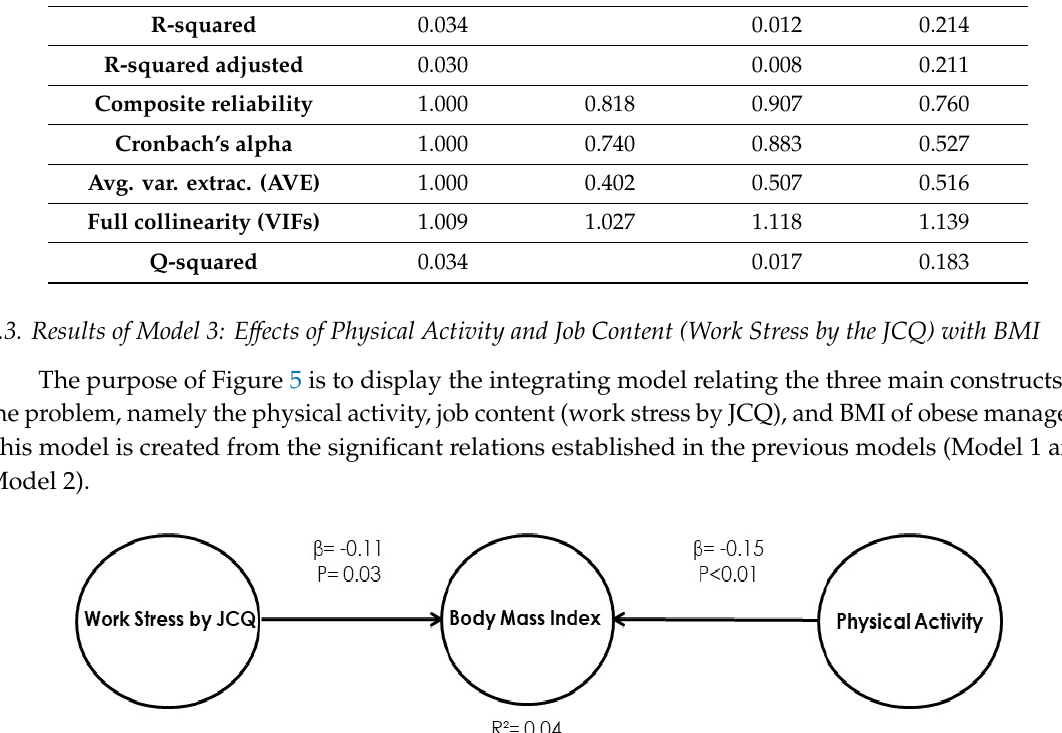
Figure 5. Model 3. Relationships between physical activity, job content (work stress by JCQ), and BMI. BMI of obese managers’ sample = −0.113 × work stress by JCQ − 0.146 × Physical Activity + Error